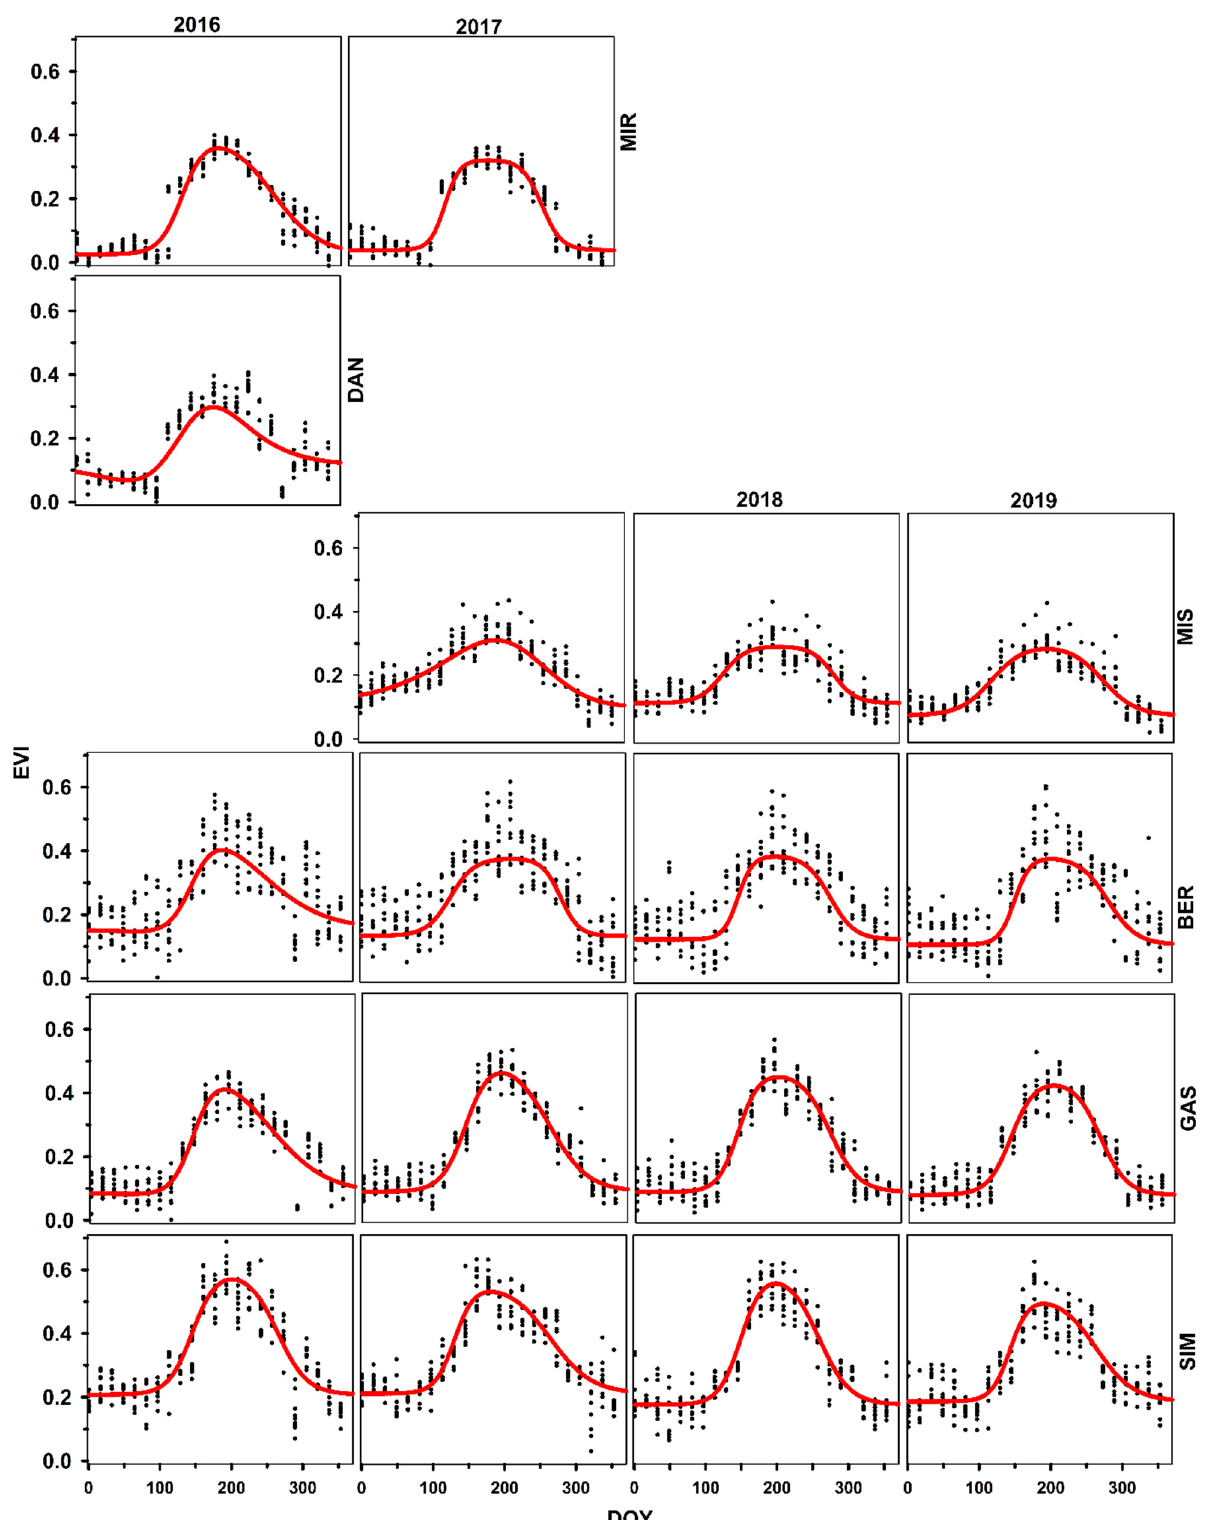
Figure 3. Time series of MODIS-EVI for different sites along the latitude in Quebec for black spruce trees. Provenances are listed according to increasing latitude of the stands of origin.